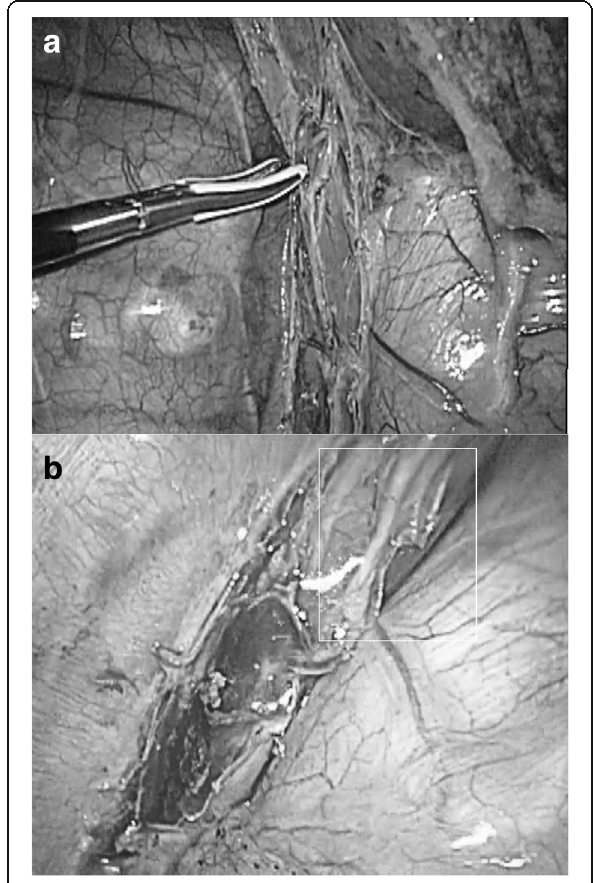
Fig. 1 Intraoperative view doing right lower lobectomy. a The inferior pulmonary ligament was divided up to the lower border of the inferior vein. No lymph node enlargement was found in the area. b No significant damage of the esophagus was identified in the magnified video-endoscopic images obtained after lobectomy (the presumable area where the fistula occurred is shown with a white